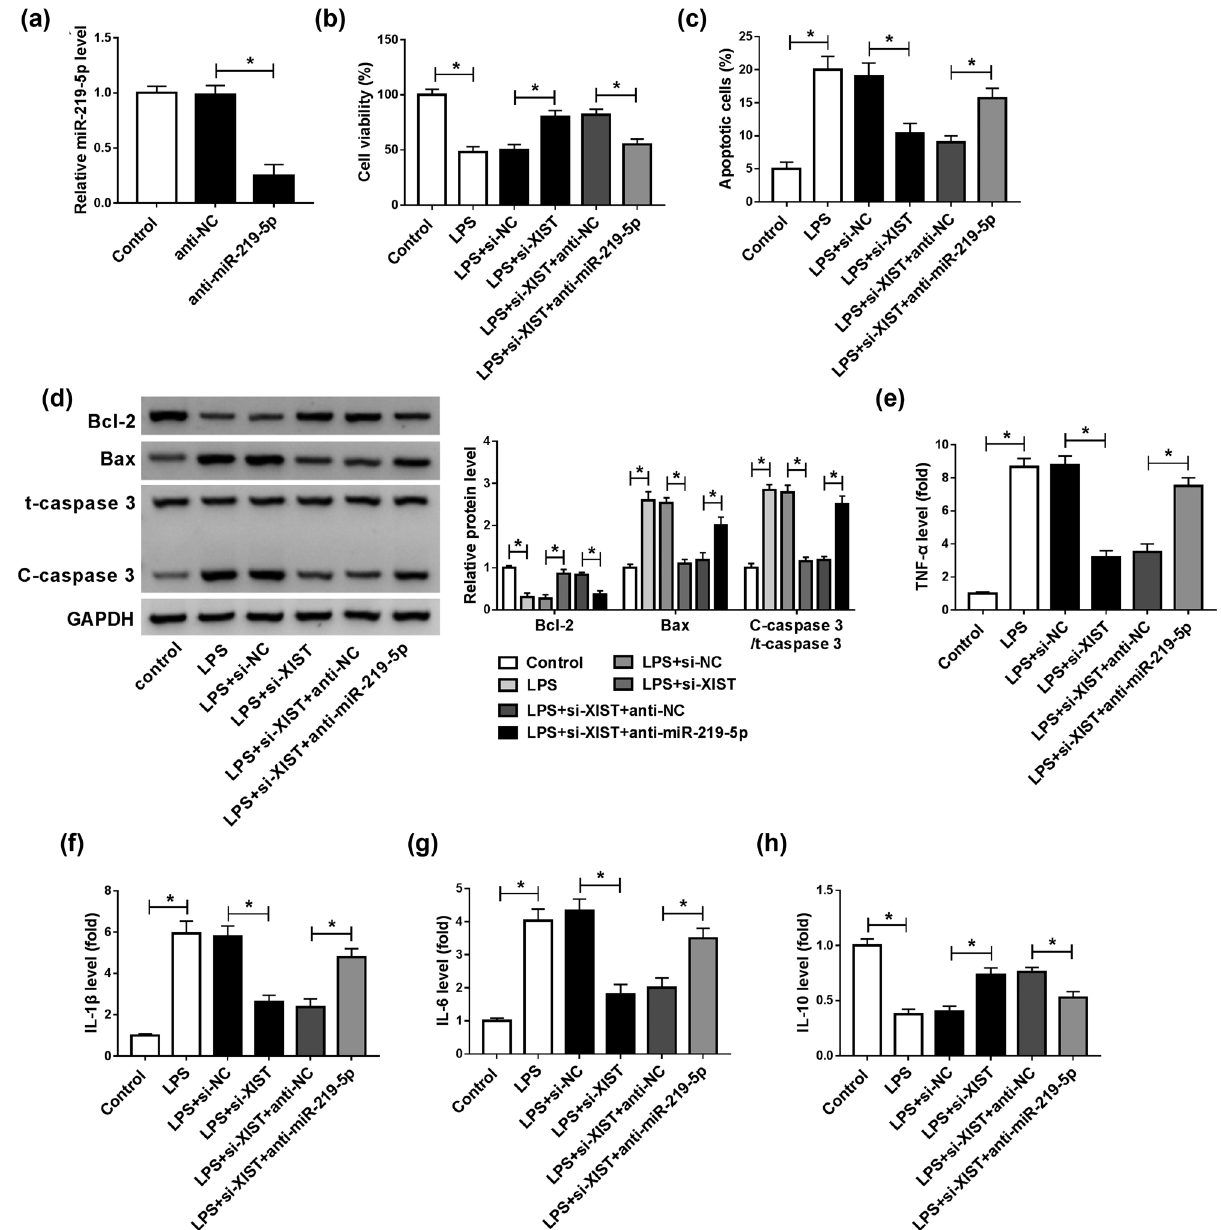
Figure 5: XIST knockdown regulated LPS - induced BV2 cell viability, apoptosis, and in fl ammatory response by interacting with miR - 219 - 5p. ( a ) The expression of miR - 219 - 5p in untransfected BV2 cells and anti - NC or anti - miR - 219 - 5p transfected BV2 cells was determined using RT - qPCR assay. ( b – h ) BV2 cells were divided into six groups: control, LPS, LPS + si - NC, LPS + si - XIST, LPS + si - XIST + anti - NC, and LPS + si - XIST + anti - miR - 219 - 5p. ( b and c ) BV2 cell viability and apoptosis were determined by CCK - 8 assay and fl ow cytometry analysis, respectively. ( d ) The protein level of Bcl - 2, Bax, t - caspase 3, and C - caspase 3 in BV2 cells were measured by western blot assay. ( e – h ) The levels of TNF - α , IL - 1 β , IL - 6, and IL - 10 in BV2 cells were detected by ELISA kits. * P <